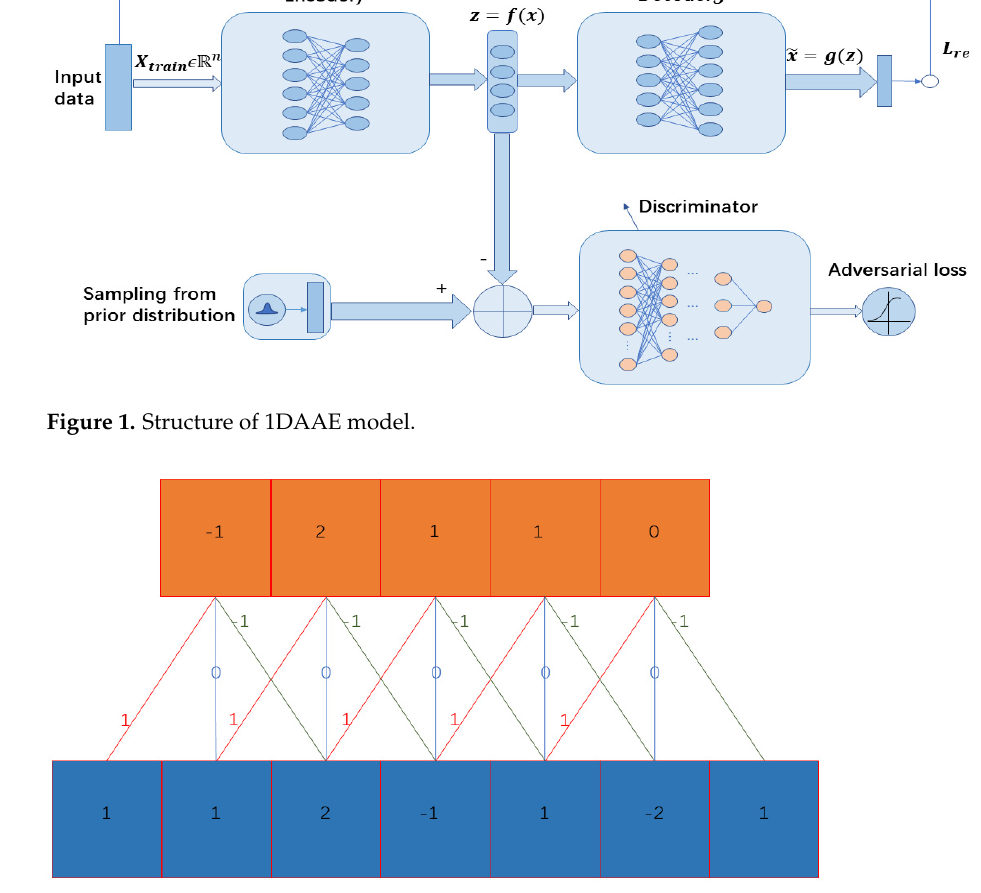
Figure 2. The principle of the 1D convolution layer.